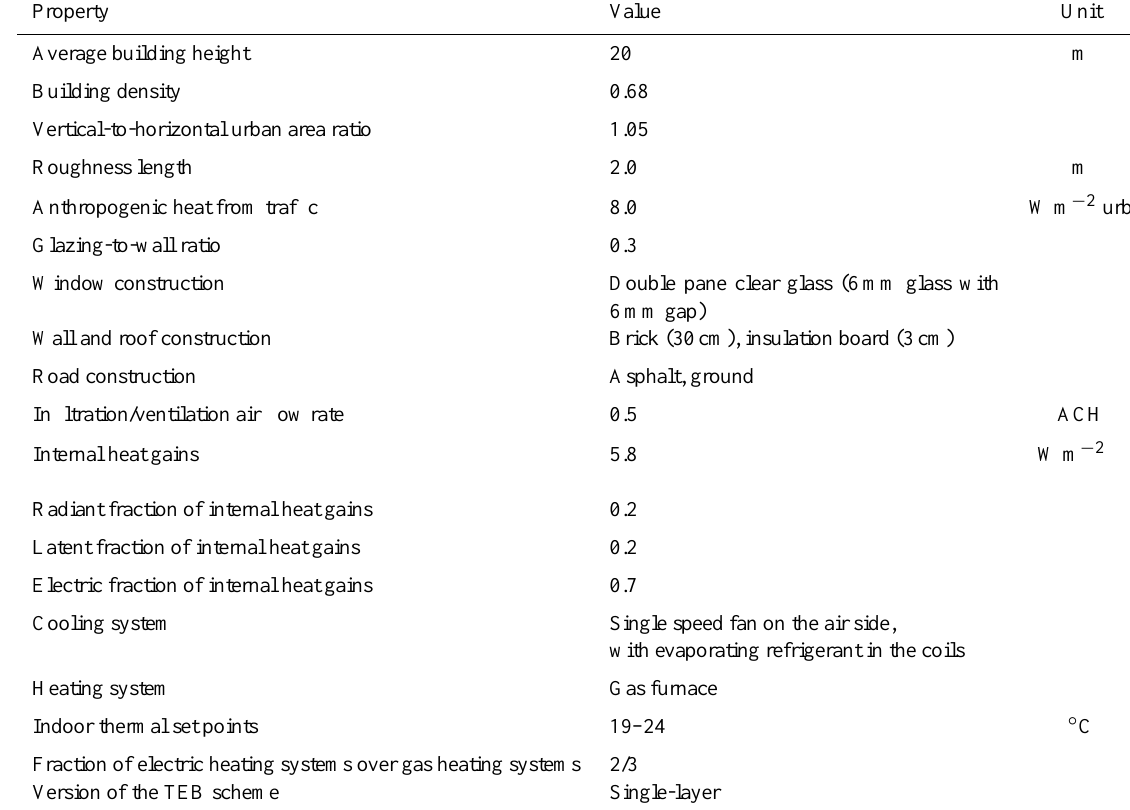
Table 3. Simulation parameters used in the comparison between the coupled scheme and BEM and between BEM and observations. This configuration represents an urban area composed of residential buildings in the dense urban centre of Toulouse,